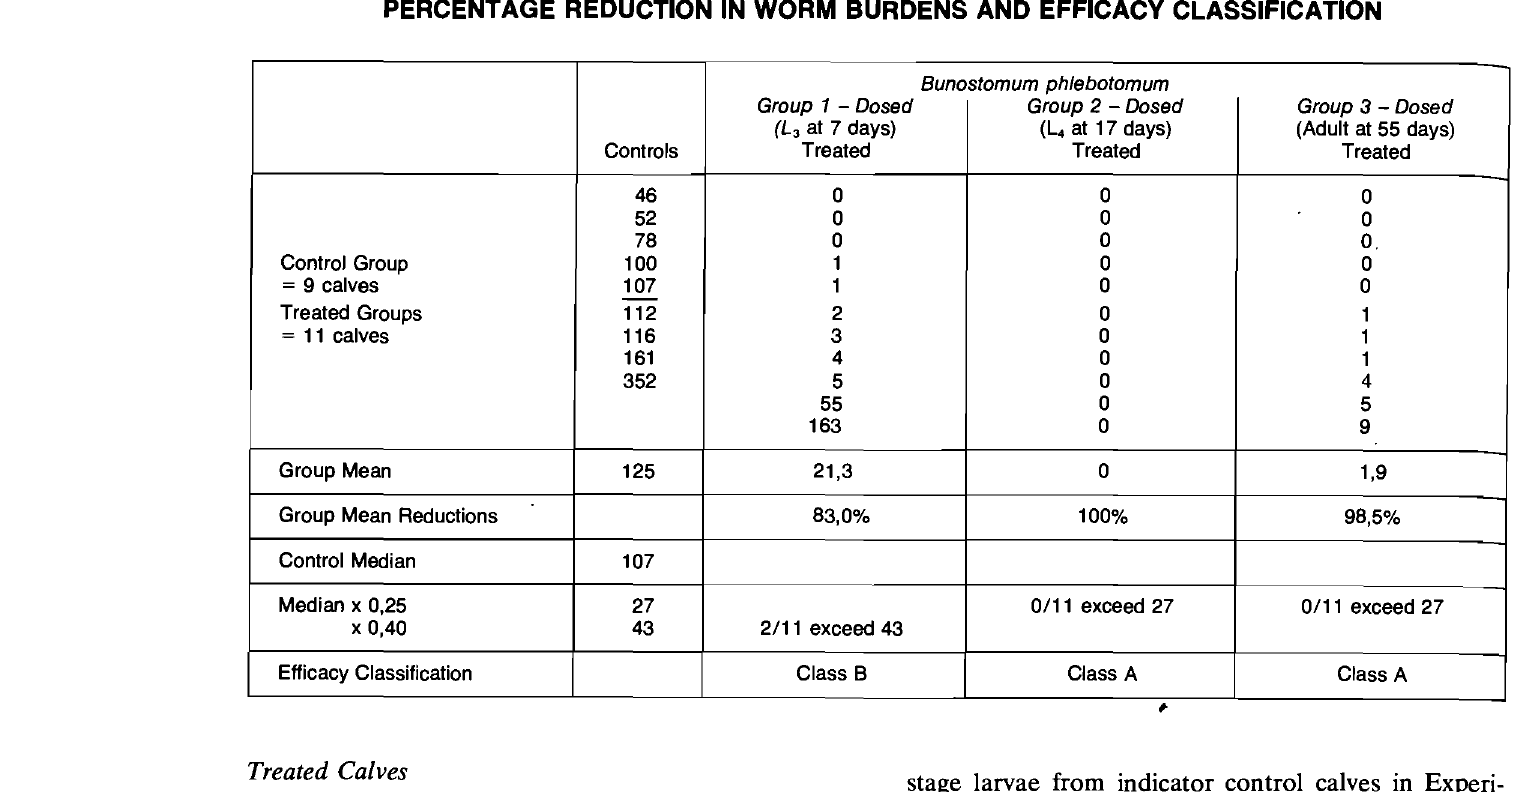
Table 6b: EXPERIMENT 7. NUMBER OF BUNOSTOMUM PHLEBOTOMUM RECOVERED AT NECROPSY, PERCENTAGE REDUCTION IN WORM BURDENS AND EFFICACY